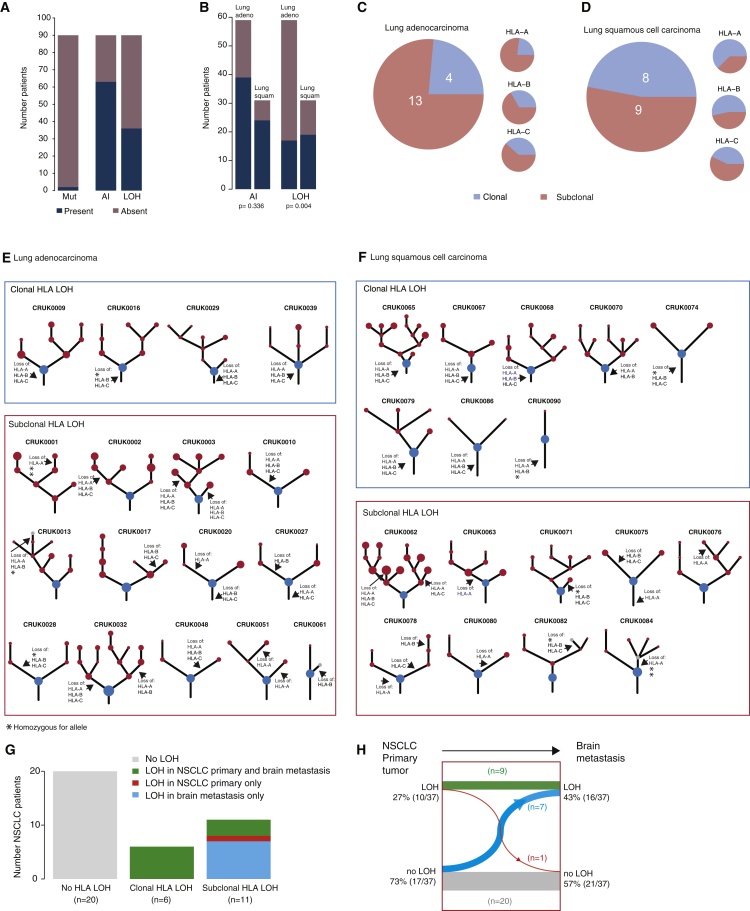
Frequency and Timing of HLA LOH in NSCLC(A) The total number of lung adenocarcinoma and lung squamous cell carcinoma TRACERx patients exhibiting an HLA non-synonymous mutation, HLA allelic imbalance (AI), or LOH at the HLA locus is shown.(B) Proportion of HLA allelic imbalance (AI) and HLA LOH identified in NSCLC by sub-type. Enrichment significance was tested using a Fisher’s exact test.(C and D) Pie charts show the timing of HLA LOH events using multi-region information for lung adenocarcinoma (C) and lung squamous cell carcinomas (D). Events at individual HLA A/B/C loci were considered clonal if they were found in every region considered and subclonal if they were found in only a subset of tumor regions. A patient sample was considered to have clonal HLA LOH if all of the individual loci lost in that tumor occurred clonally. Two lung squamous cell carcinoma patients with only a single region available for copy-number analysis are not shown.(E and F) Phylogenetic trees for each lung adenocarcinoma (E) and lung squamous cell carcinomas (F) showing evidence of HLA LOH have been annotated with the most likely timing of the HLA LOH event. Homozygous HLA alleles, where HLA LOH is not possible, are indicated by an asterisk. Clones on the phylogenetic tree (nodes) are indicated as clonal (blue) or subclonal (red). In cases where the HLA LOH event did not map to a possible clone on the phylogenetic tree, an additional gray subclone was included.(G) Number of NSCLC patients from Brastianos et al. (2015) with paired primary/brain metastasis sequencing data available exhibiting no HLA LOH (gray), HLA LOH in both the primary tumor and brain metastasis (green), HLA LOH only in the primary tumor (red), or HLA LOH only in the brain metastasis (blue). Patients with HLA LOH identified consistently across HLA loci in both the primary tumor and every brain metastases were considered to have clonal HLA LOH. Patients with inconsistent HLA loci subject to LOH or those with HLA LOH identified in only a primary or brain metastasis sample were considered to have subclonal HLA LOH.(H) Timing of the HLA LOH events. Clonal HLA LOH events occur in both the primary tumor sample and the brain metastases (green), whereas subclonal HLA LOH events either arise in the brain metastases (blue) or have occurred in a subclone of the primary tumor that does not seed the brain metastasis (red). Overall, an increase in HLA LOH is observed in the brain metastases samples as compared to the primary tumor (27% to 43%) and a corresponding decrease is observed in brain metastases samples exhibiting no HLA LOH (73% to 57%).